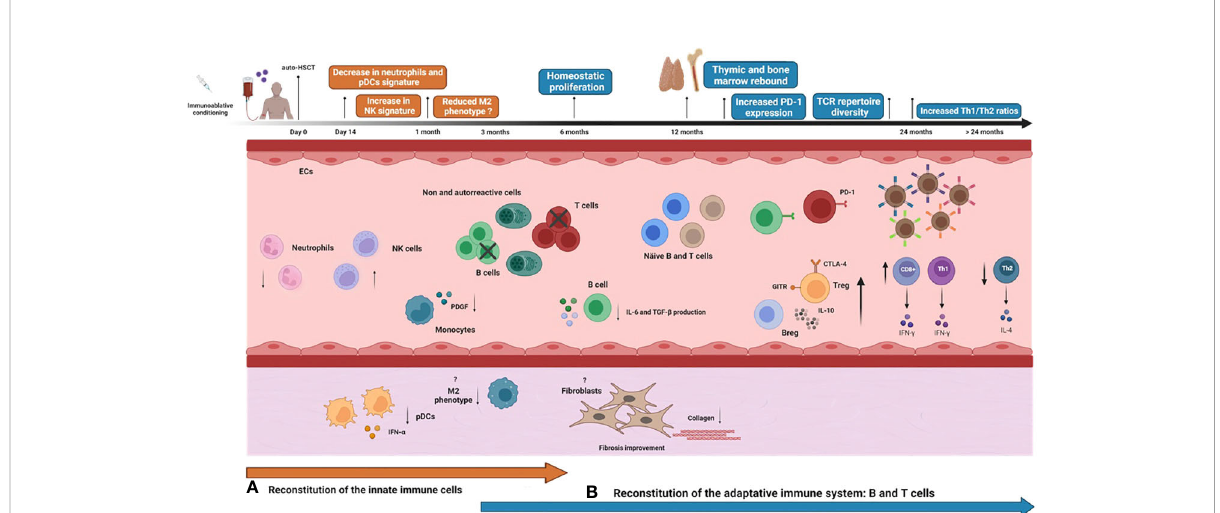
FIGURE 1 Immune reconstitution over time after auto-HSCT in systemic sclerosis patients. Systemic sclerosis (SSc) patients undergoing autologous hematopoietic stem cell transplantation (auto-HSCT) are treated with an immunoablative conditioning regimen consisting of high doses of chemotherapy/radiotherapy/immunotherapy agents, usually cyclophosphamide plus anti-thymocyte globulin. Then, previously collected autologous hematopoietic stem and progenitor cells (HSPCs) are thawed and administered to the patient intravenously. The graft may be CD34 + selected or non-manipulated, according to institutional protocols. After a period of bone marrow aplasia, there is hematological and immunological recovery, and the innate immune system recovers earlier than the adaptive system. Neutrophils are the fi rst immune cell type to reconstitute, generally within the fi rst 14 days after infusion of the HSPC graft. Neutrophil gene expression signatures signi fi cantly decrease after auto-HSCT. Other innate immune cells, such as monocytes, natural killer (NK) cells, and dendritic cells (DCs), achieve normal counts within the fi rst month after transplantation. At this point, increased transcription signature of circulating NK cells is reported. In parallel, SSc skin biopsies post-auto-HSCT show signi fi cant reductions in mRNA expressions of plasmacytoid dendritic cells (pDC) and IFN- a responses. Alternatively-activated monocytes with an M2 phenotype signi fi cantly diminish post-transplantation. Plasma levels of platelet-derived growth factor (PDGF), an important molecule involved in fi brosis that positively correlates with the number of circulating monocytes in SSc, reduce signi fi cantly at six months after auto-HSCT.